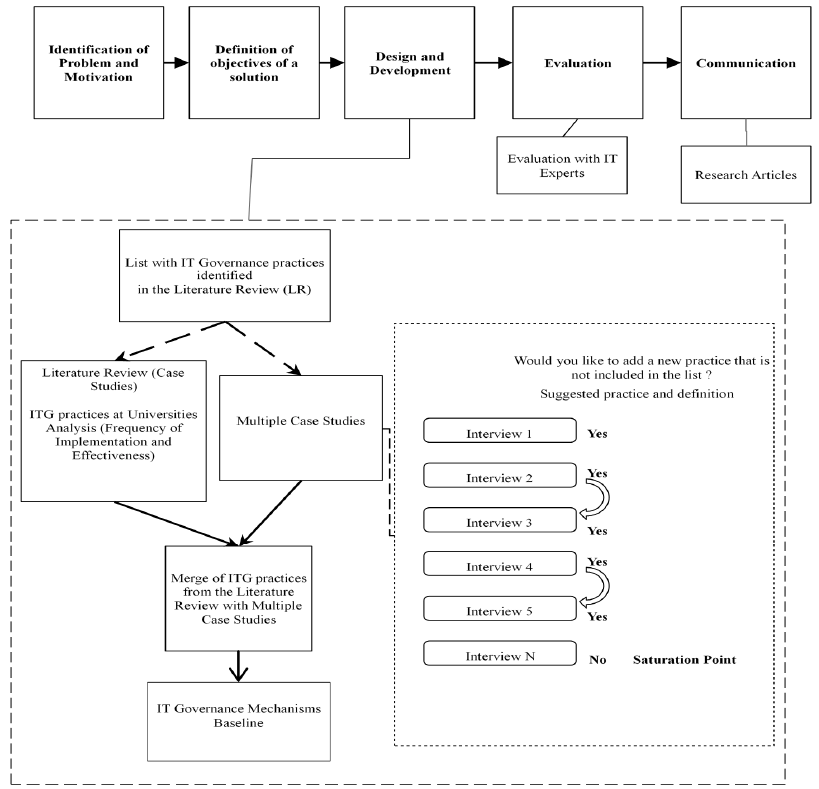
Figure 1. Design science research (DSR)—Design and development of ITG mechanism’s baseline.